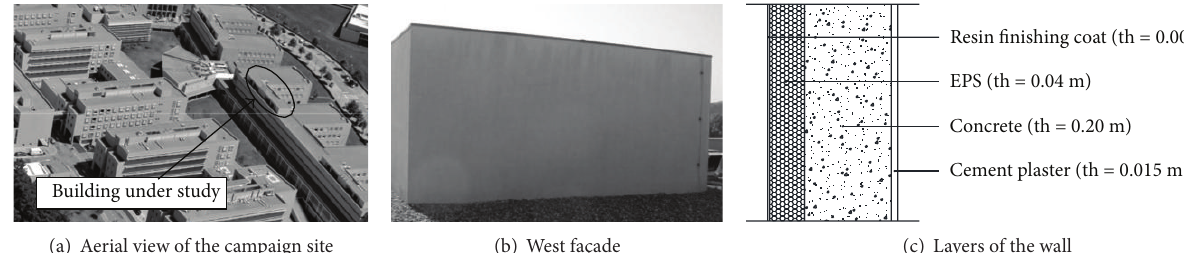
Figure 6: Building under study, located in University of Porto campus,